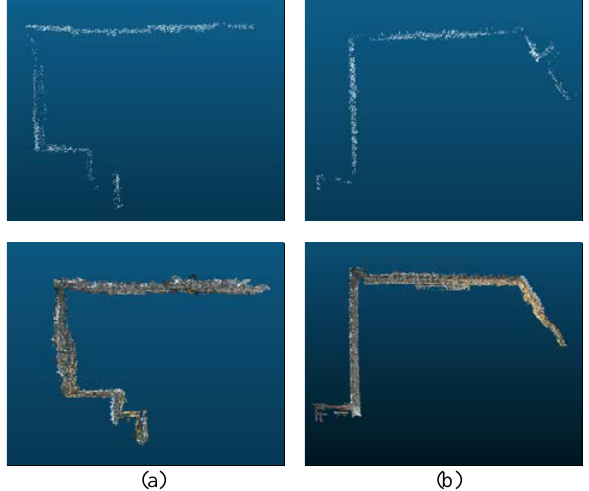
Figure 9. Two visible building outlines extracted from airborne LiDAR (top) and ground image point clouds (bottom).